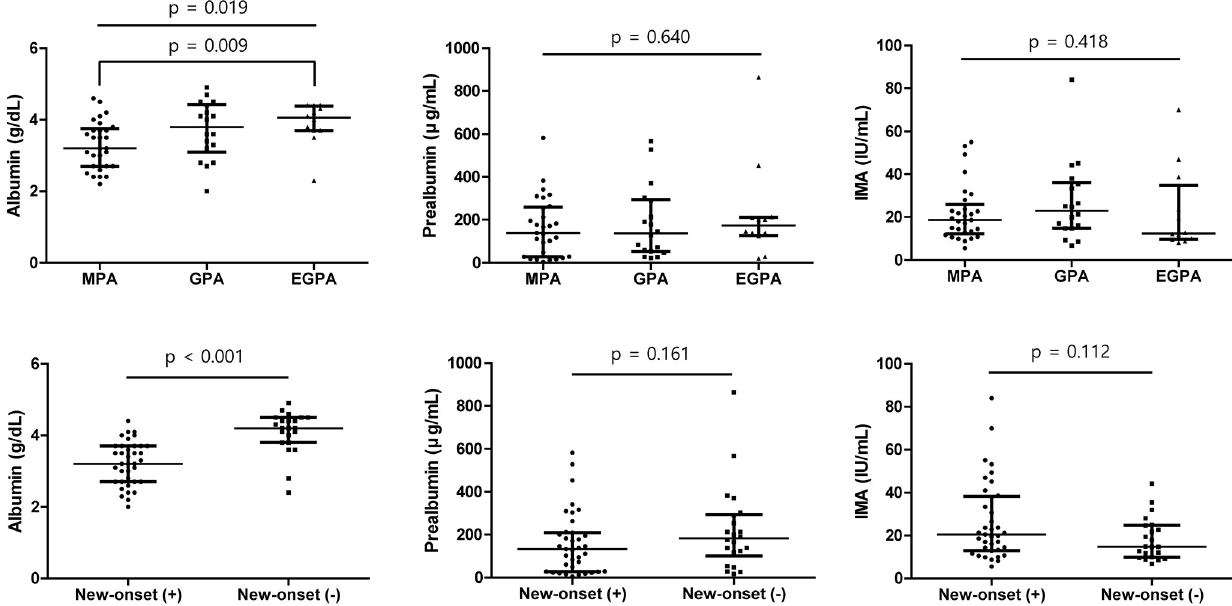
Fig 5. Levels of initial albumin, prealbumin, and ischemia-modified albumin based on disease diagnosis and new-onset disease. Patients with MPA had significantly lower albumin level compared to those with EGPA, but prealbumin and ischemia-modified albumin levels were comparable in patients with MPA, GPA, and EGPA. Among patients with and without new-onset disease, a significantly decreased albumin level was observed in those with new- onset disease, while no difference was noted regarding prealbumin and ischemia-modified albumin levels. The error bars present median and interquartile range. MPA: microscopic polyangiitis; EGPA: eosinophilic granulomatosis with polyangiitis GPA: granulomatosis with polyangiitis.